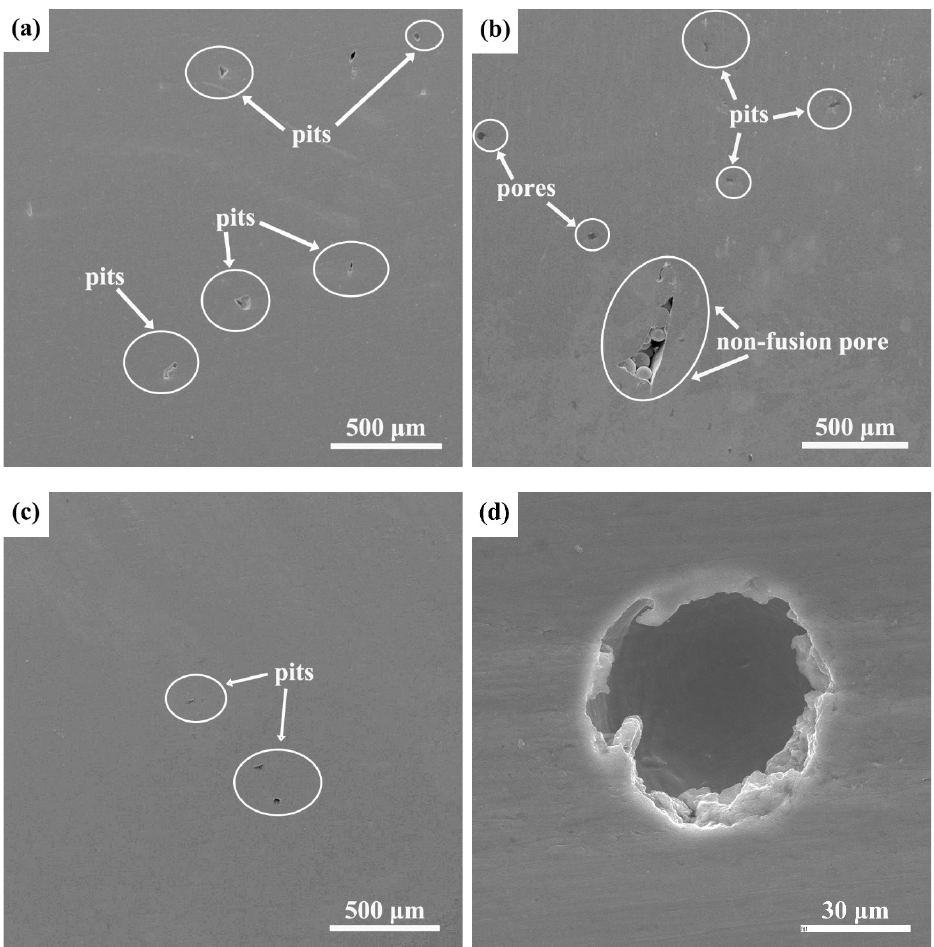
Figure 9. SEM images of the surface of ( a ) SLM- and ( b ) EBM-manufactured Ti-6Al-4V alloy samples, and ( c ) ISF alloy after the potentiodynamic polarization in a 3.5 wt.% NaCl solution, and ( d ) a magnified view of a hollow hole from ( b